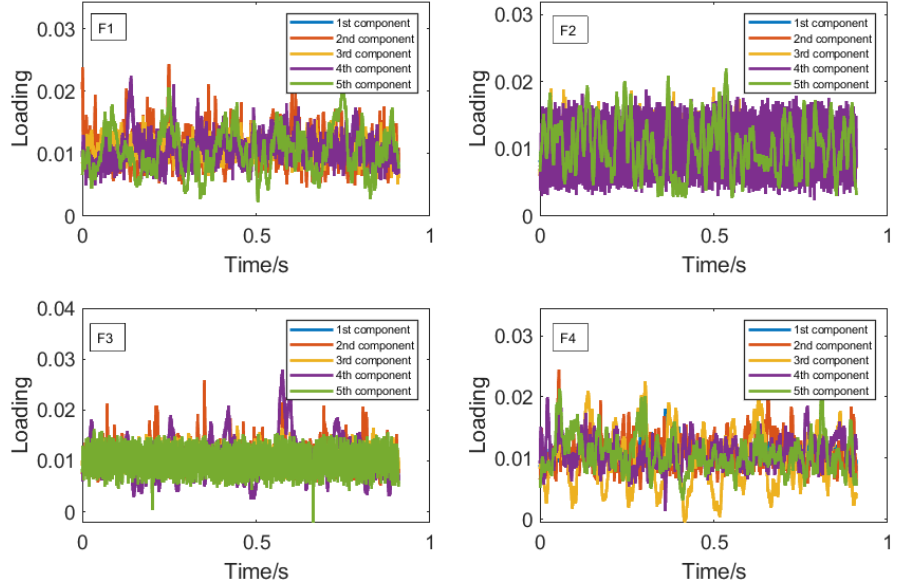
Figure 13. 1200 rpm centrifugal pump signal decomposition in Mode3: ( F1 ) for normal impeller, ( F2 ) for blade damage, ( F3 ) for impeller edge damage, ( F4 ) for impeller perforation damage. The multi-channel complex signals are obtained from the centrifugal pump, which are analyzed by parallel factor decomposition to obtain the time and frequency infor- mation matrices. The time matrices as shown in Figure 13 are analyzed by Discrete Fourier Transform (DFT) to obtain the frequency domain information. DFT is defined as follows: